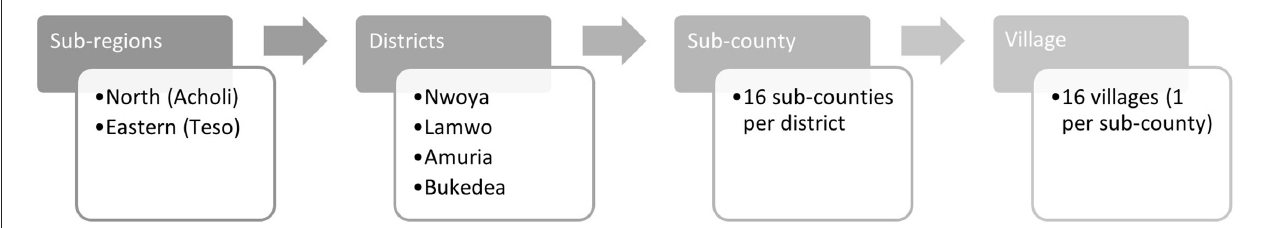
FIGURE 2 | Multi-stage sampling process to select the focus group